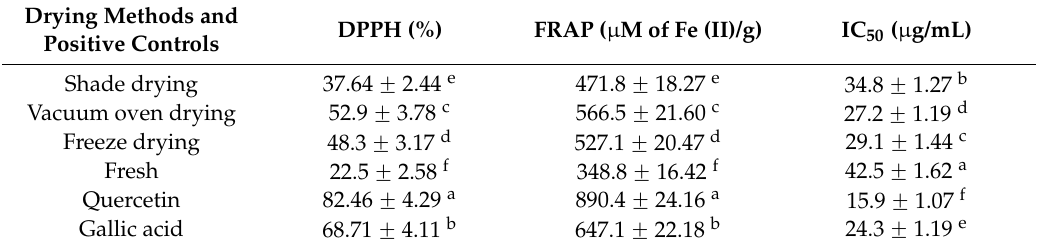
Table 3. Antioxidant activities of Z. officinale var. rubrum Theilade rhizome dried with different methods. Drying Methods